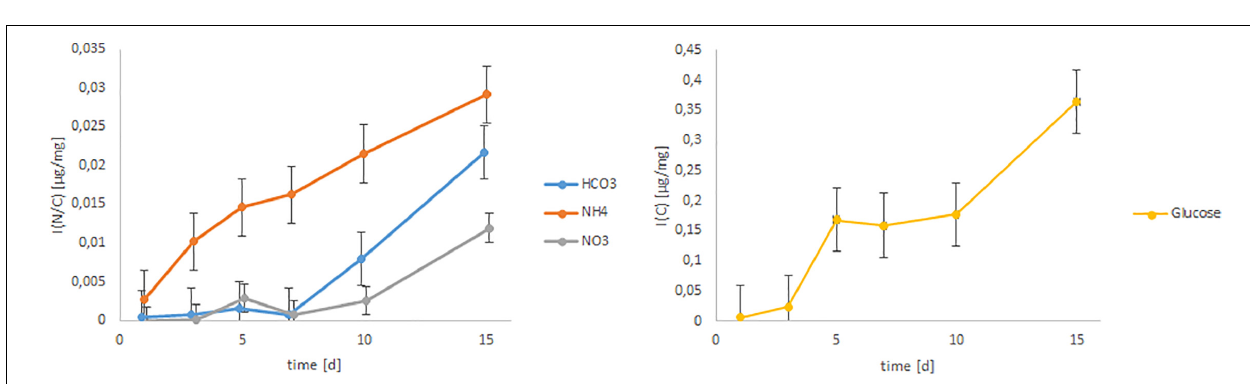
FIGURE 4 | Incorporated amount of 15 N or 13 C from bicarbonate, glucose, ammonium and nitrate over time. The datapoints were calculated from n = 3 replicates and the error bars indicate the standard